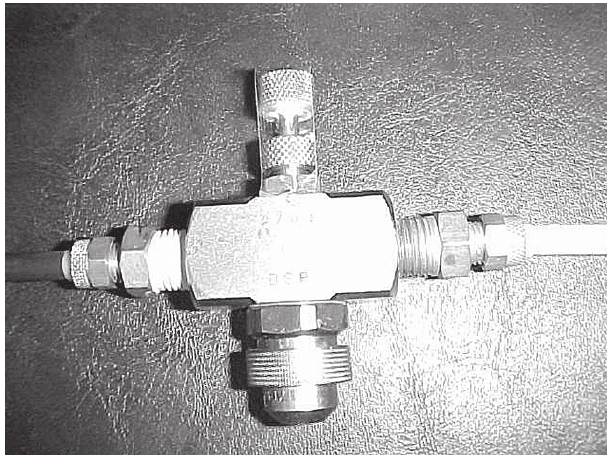
Figure 2. Nozzle used in microsphere obtention.